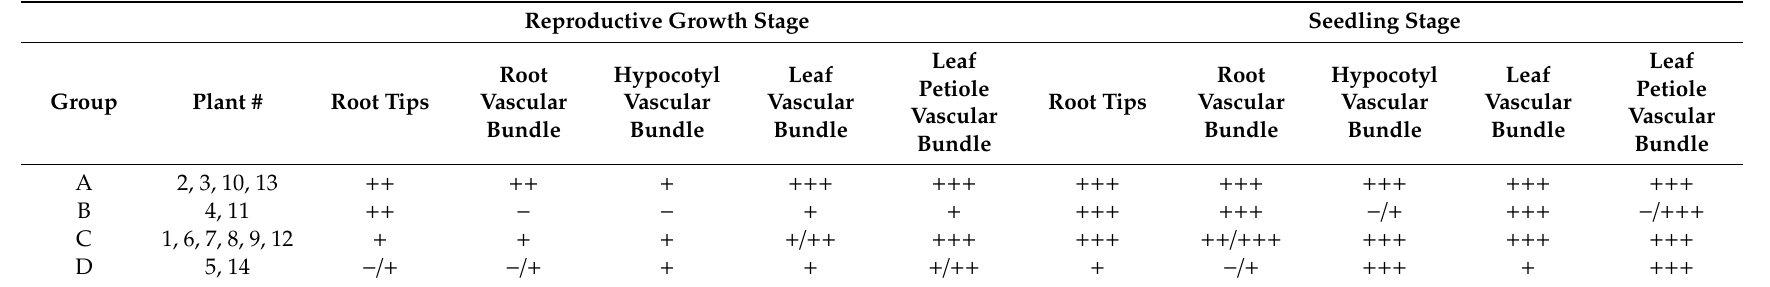
Table 1. Expression profile of AtHKT1;1pro–GUS in